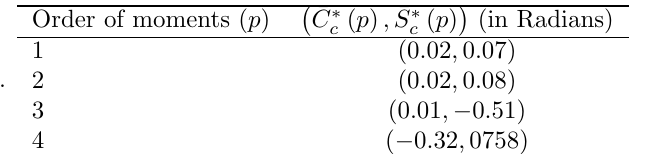
Adjusted Censored Sample Trigonometric Moments about the Zero Direction for data shown in Table (2)